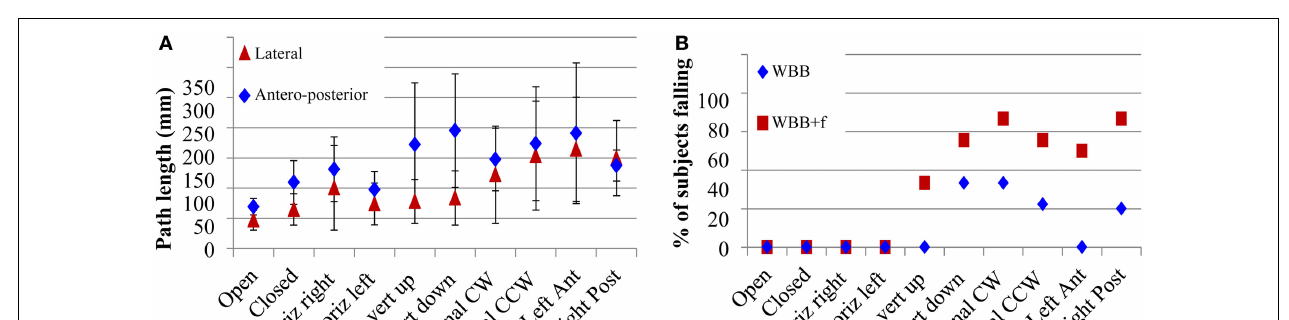
(B) Percentage of subjects falling depending on the intensity of moving scene with eyes open and closed, as well as during stimulation using virtual reality.